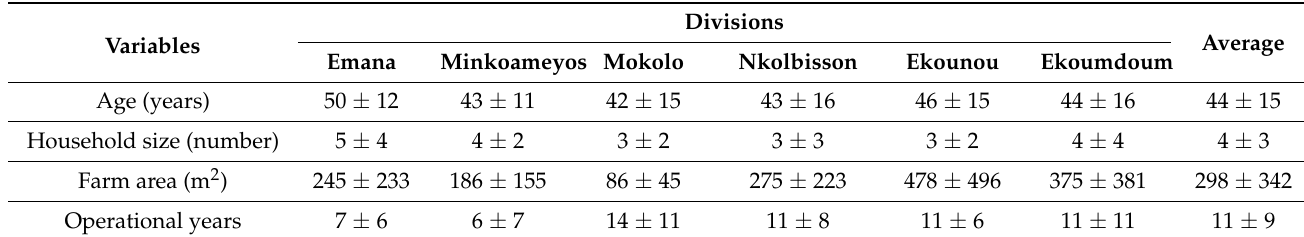
Table 2. Summary of ages and farm characteristics ( ± standard deviation), N = 130.